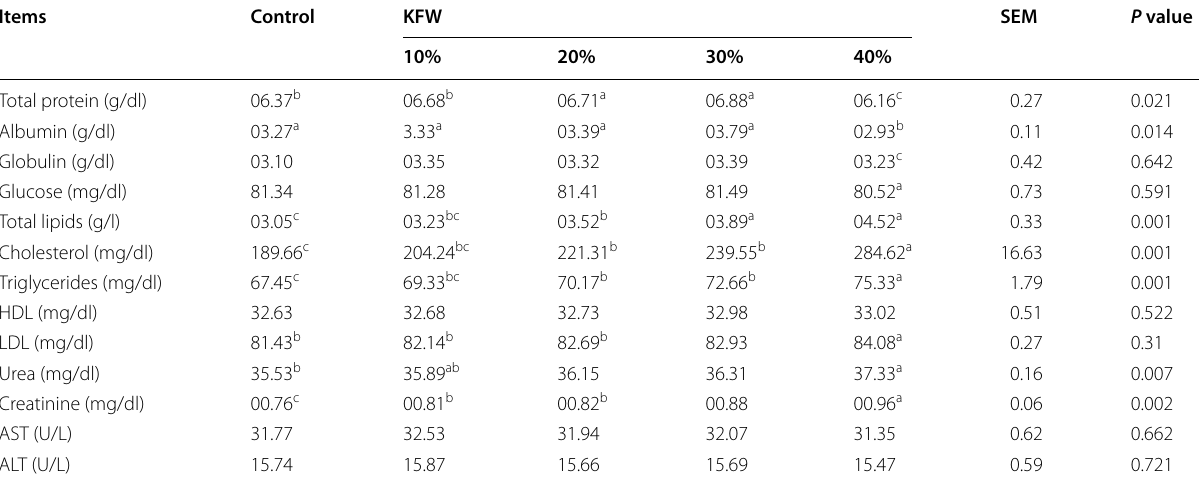
a,b,c Mean in the same row bearing different superscripts are significantly different